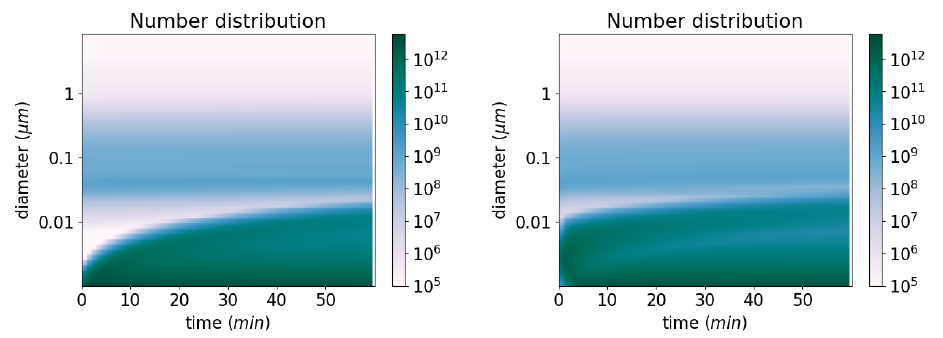
Figure 12. Time evolution of the number distribution (# m − 3 ) for the different size sections, without Monomer ( left ) and with Monomer ( right